Question: Briefly state, in one sentence, what is plotted here.
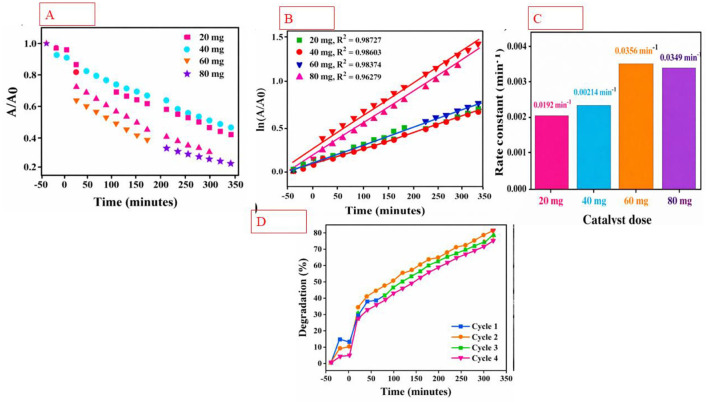
Answer: Photocatalytic activity: (A) UV-Vis absorption spectra of RhB at different irradiation time, (B) Pseudo-first-order kinetic plot (ln(A/A0) vs. time), (C) Degradation efficiency (mean ± SD; n = 3; * p < 0.001) with increase in catalyst loading and rate constants are annotated, (D) Reusability of Fe 2 O 3 nanoparticles across four consecutive cycles.